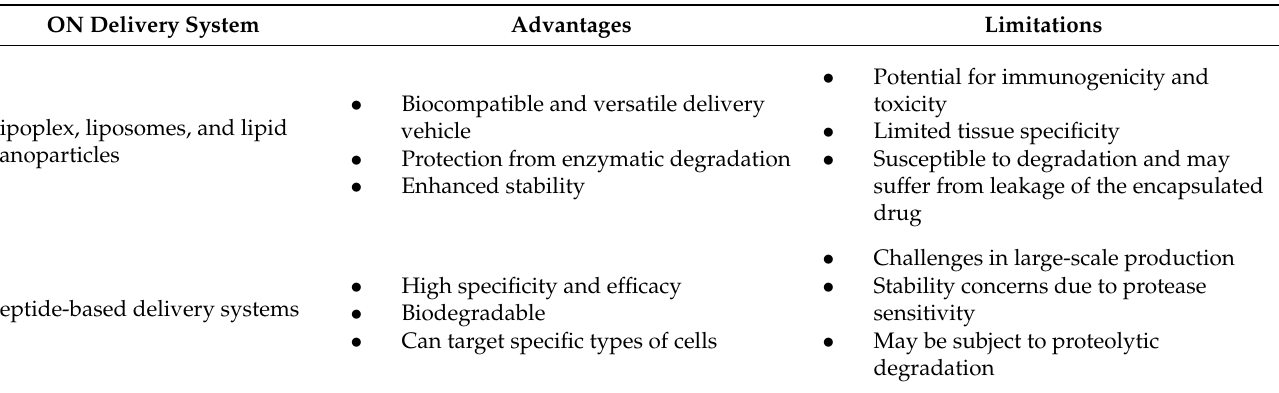
Table 2. ON delivery systems. This outlines the general advantages and disadvantages of each delivery system and its potential for use with each ON